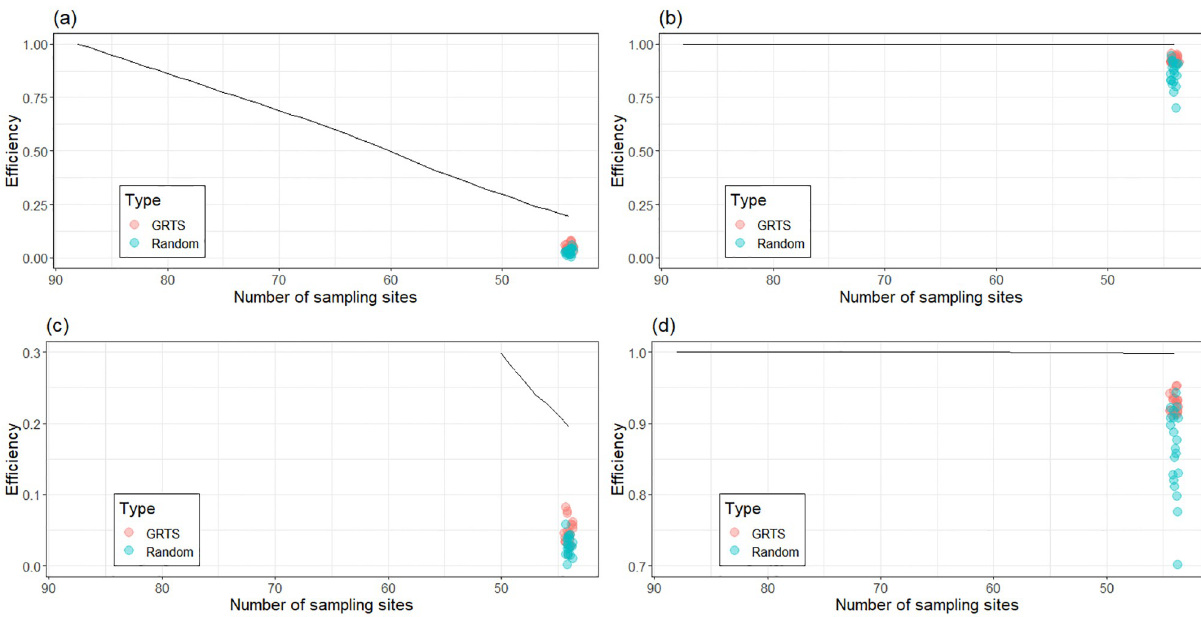
Fig 4. Information loss in our optimal designs as we remove sites one-by-one using the (a, c) CPD-optimal and (b, d) K-optimal utility functions. The panels (a) and (b) have axes for efficiency fixed between 0 and 1. Panel (c) is zoomed on the y-axis range 0-0.3 and panel (d) on the y-axis range 0.7- 1.0. Efficiency represents a ratio of the expected utilities of each design and the full 88 site design. The black line indicates the efficiency of the optimal design with a certain number of sampling sites. The 20 red dots and 20 blue dots in each panel represent the efficiencies of 44-site GRTS and random designs, respectively. These serve as a baseline measure of comparison for the optimal design, which should have higher relative efficiency. We only compare the efficiencies of the GRTS, random and optimal designs when there are 44 sampling sites in the design because the 44 site monitoring program is the final